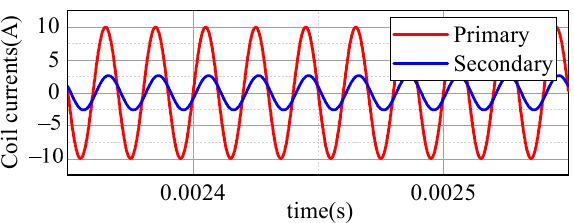
Figure 36. Coupler currents waves with the conventional structure shield.